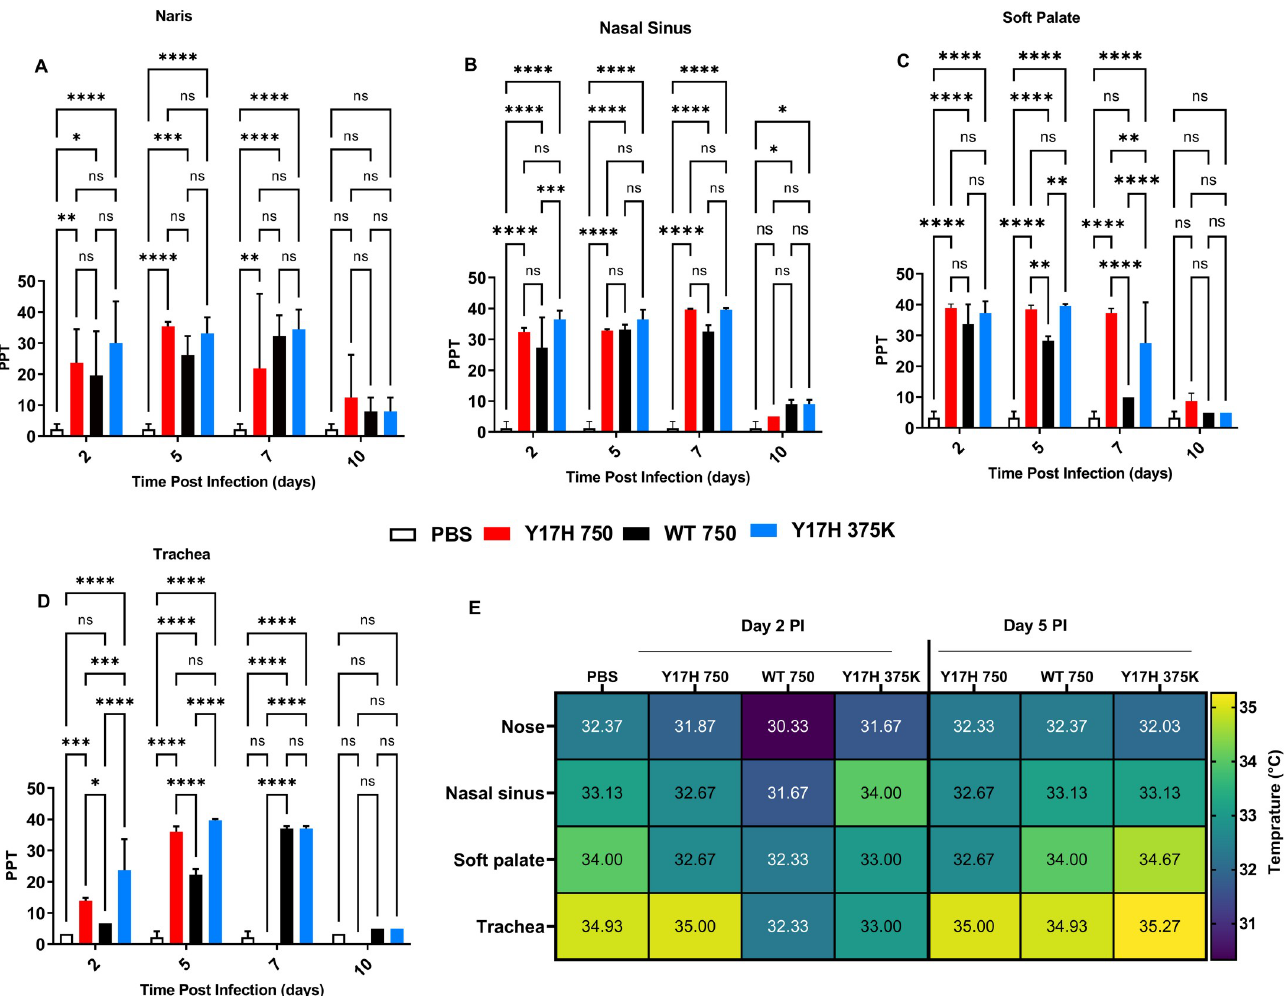
Fig 4. Extracellular respiratory tract salinity and temperature in DBA/2 mice after infection. Mice were intranasally inoculated with PBS, WT virus (750 PFU), or Y17H virus (750 or 375,000 PFU). (A-D) Values from nares, nasal cavity, soft palate, and tracheal salinity expressed as parts per thousand (PPT). After 2, 5, 7, or 10 days of infection, extracellular salinity and temperature were recorded. Reported values are means ± SD ( n = 10). Two way-ANOVA and Tukey posthoc tests were performed separately for each day, and significant statistical differences are indicated as follows: � P < 0.5, ��� P < 0.01, ��� P < 0.001, and ���� P < 0.0001. ( E ) Summary of temperature values (degrees Celsius) for each group with a colored heat map